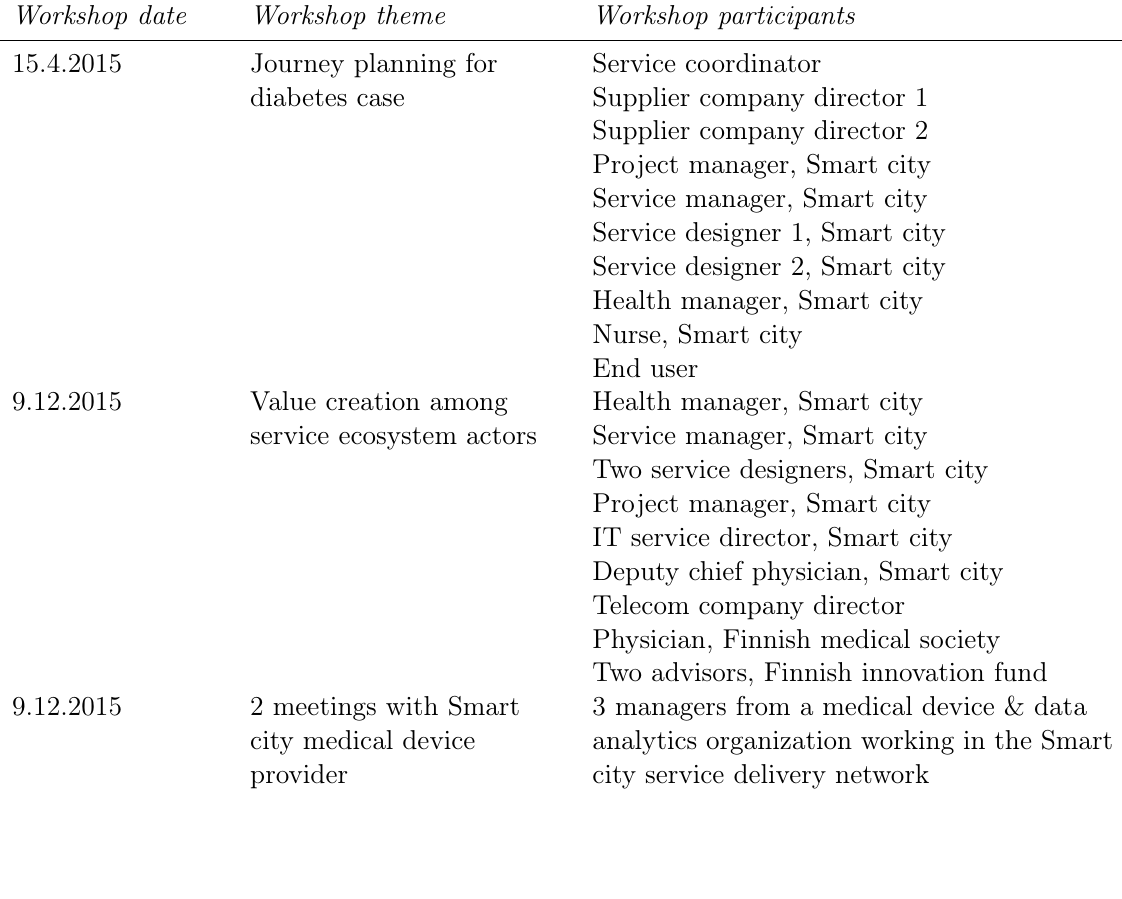
Table 2. Participants in the